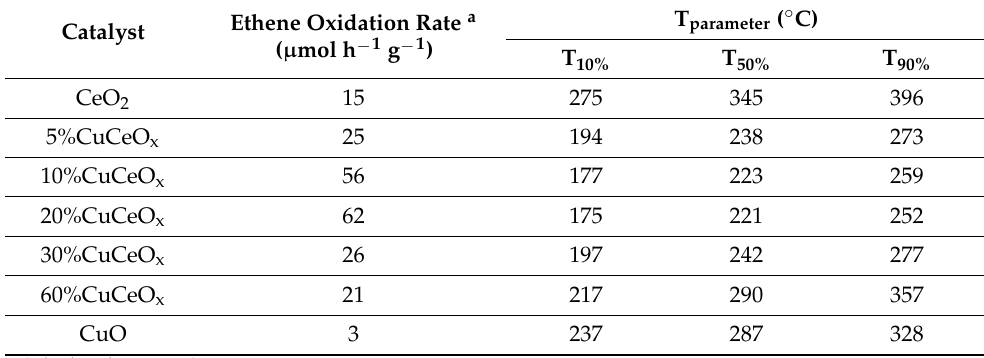
Figure 12. Catalytic conversion (%) of ethene over the synthesized catalysts as a function of the temperature. Table 7. Catalytic performances of the prepared samples in the catalytic oxidation of C 2 H 4